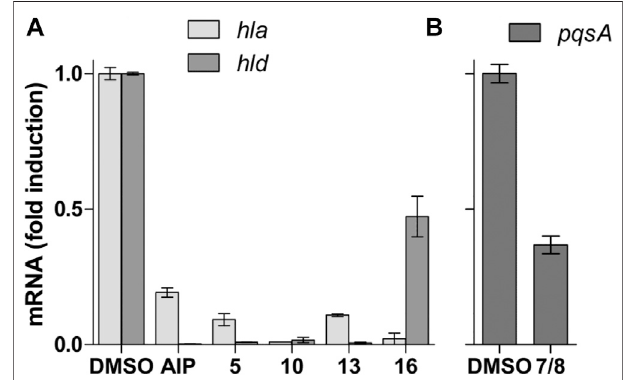
FIGURE 7 | (A) Quantitative PCR test of S. aureus QS regulated genes hla and hld . AIP (auto-inducer from S. caprae ) is used as the positive inhibitor control. (B) Quantitative PCR test of P. aeruginosa for QS regulated gene pqsA . Fold induction is represented relative to DMSO alone ( fi xed at